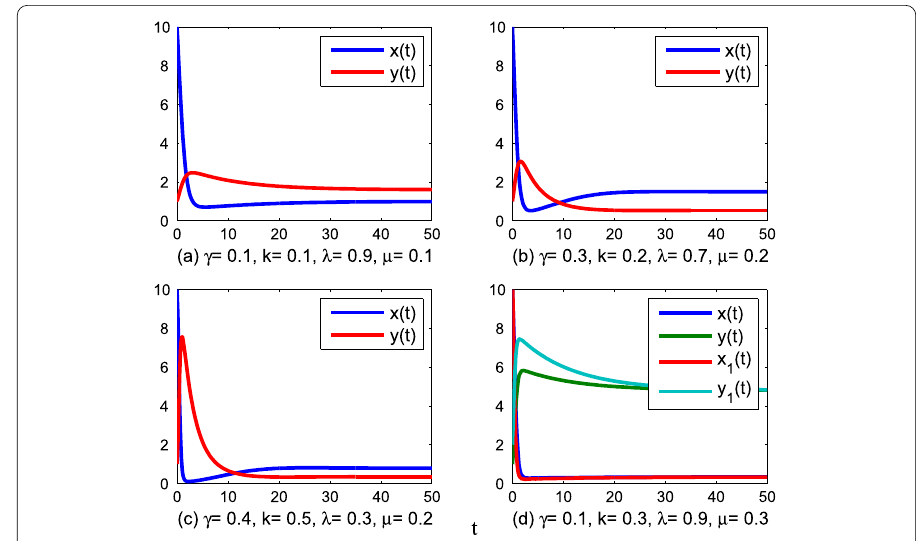
Figure 2 The first three figures show the curves of target cells x ( t ) and the immune cells induced y ( t ) at β = 0.5, x (0) = 10, y (0) = 1, and different values of the parameters. The fourth one shows that it does not depend on the initial values of x ( t ), y ( t ) where we take another initial values x 1 (0) = 11, y 1 (0) =